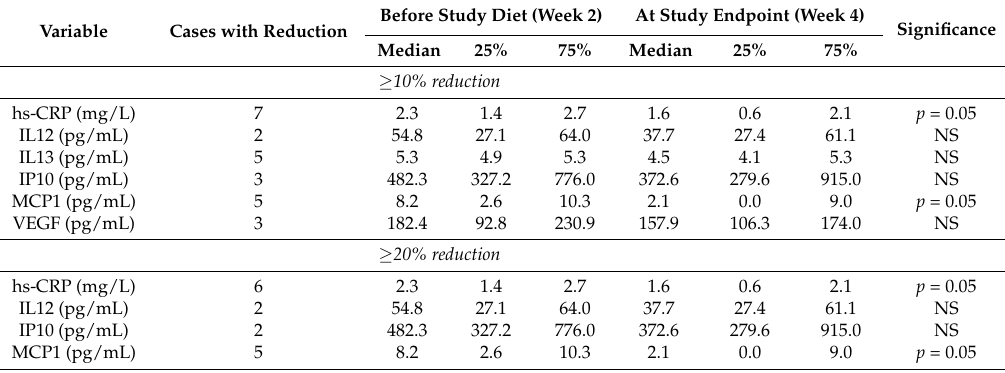
Table 3. Median and 25th and 75th percentile of high sensitivity C-reactive protein (hs-CRP) and pro-inflammatory cytokines in individuals with type 2 diabetes at 2 weeks (before intake of study diet), and after two weeks with the study diet. Presentation of cases with either 10% or 20% reduction of pro-inflammatory cytokines. Before Study Diet (Week 2) At Study Endpoint (Week 4) Significance Variable Cases with Reduction